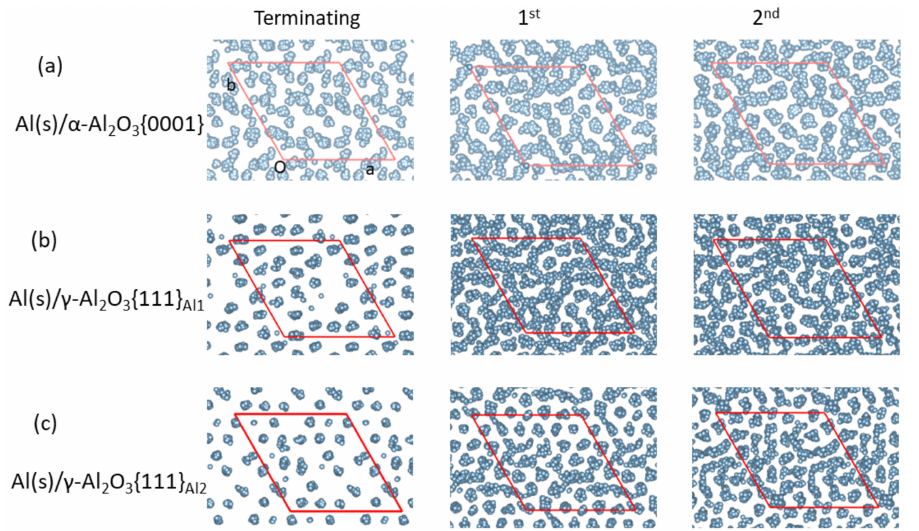
Figure 5. Al( l )/ γ -Al 2 O 3 {1 1 1} Al_2 interface exhibits more notable prenucleation with atomic or- dering and stronger localization at the 1st Al layer than the other interfaces. Time averaged atomic arrangements in the terminating, 1st and 2nd Al layers at the equilibrated ( a ) Al( l )/ α -Al 2 O 3 {0 0 0 1}, ( b ) Al( l )/ γ -Al 2 O 3 {1 1 1} Al_1 and ( c ) Al( l )/ γ -Al 2 O 3 {1 1 1} Al_2 interfaces